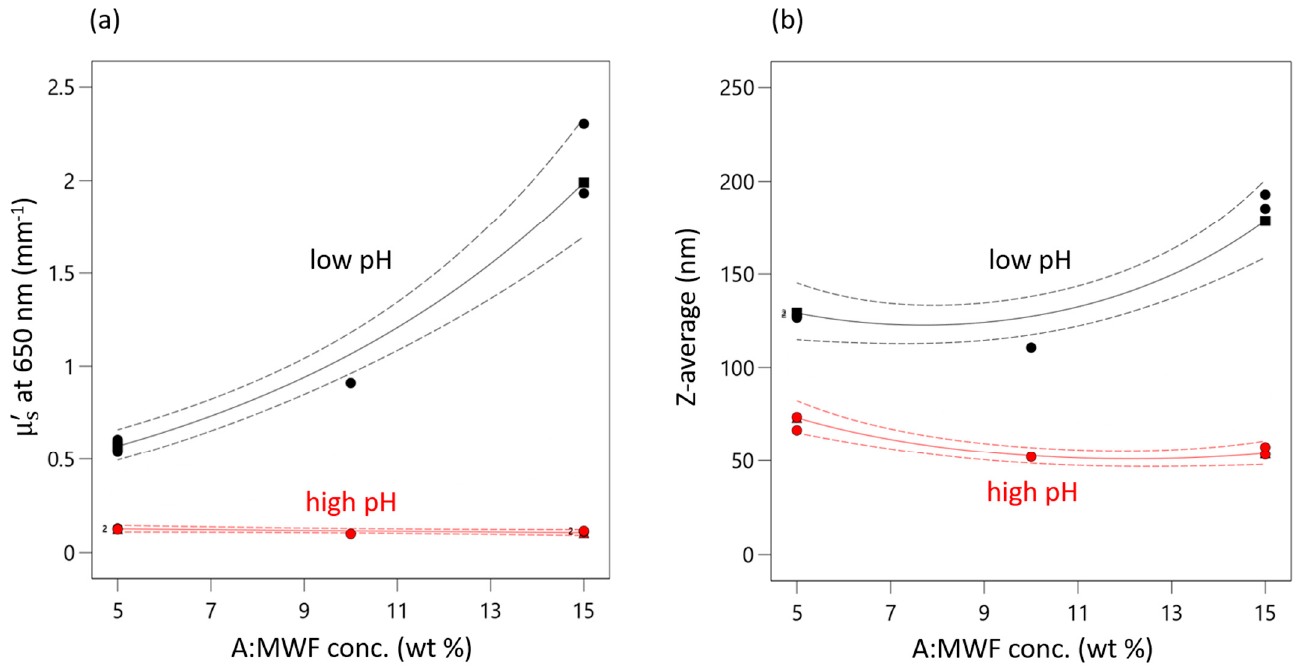
Figure 3. Interaction plot of AB interaction for ( a) µ ’ s and ( b ) Z-average. Red triangles indicate responses measured at high pHs. Black squares indicate measured response at low pHs. Green circles indicate measured response at medium pH. Dashed lines indicate 95% confidential intervals.